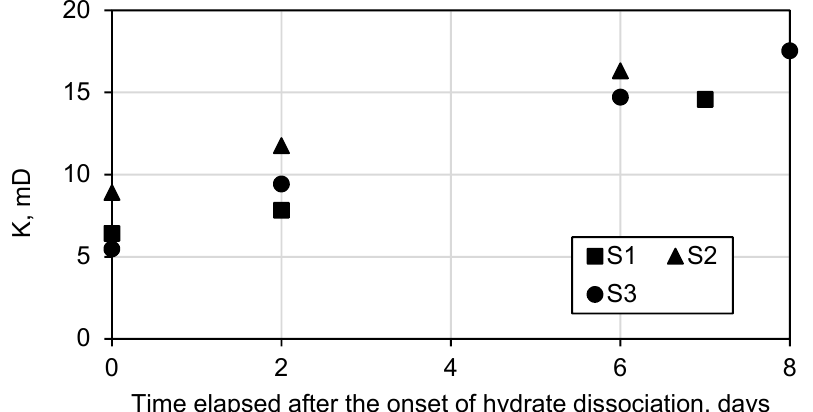
Figure 7. Gas permeability of frozen sand saturated with CO 2 hydrate at below-equilibrium pressure and nitrogen injection to 3 MPa, at − 5 °C.